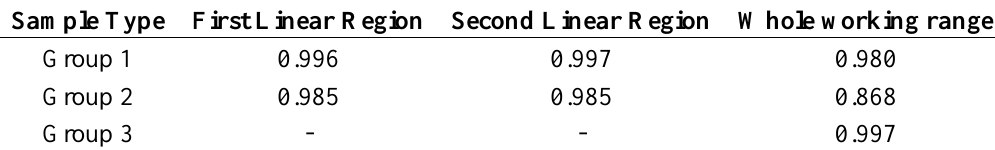
Table 3. R 2 values of knitted